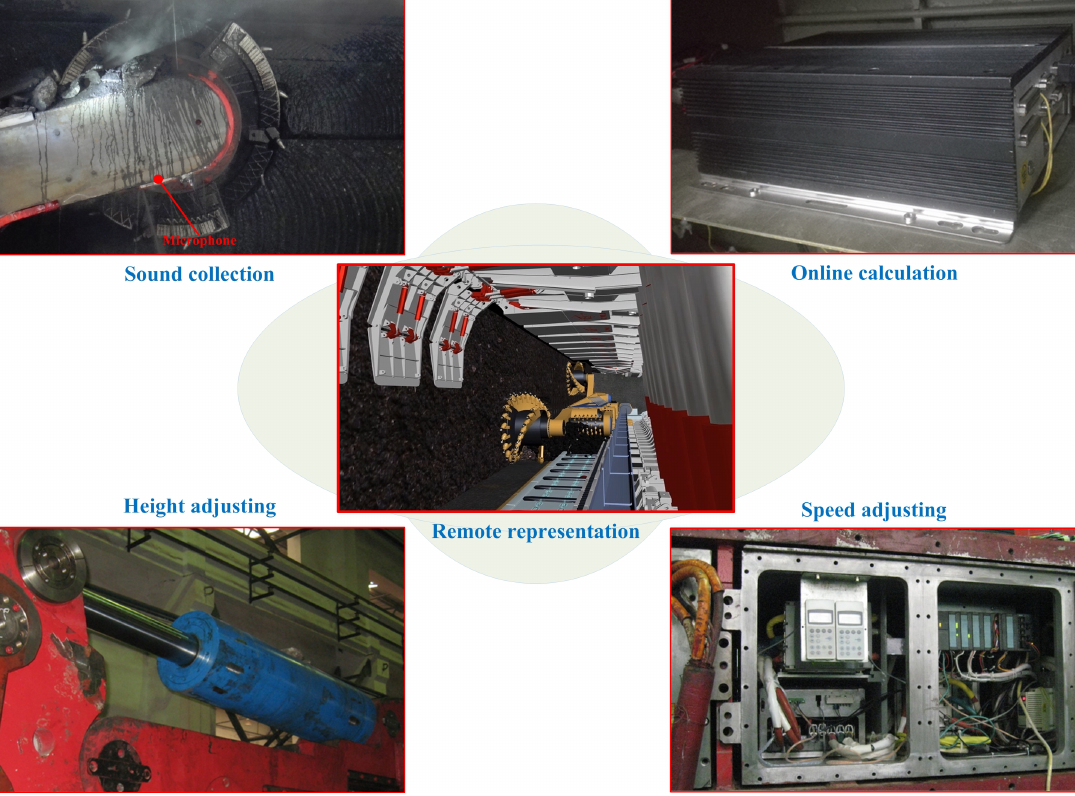
Figure 10. Online cutting pattern recognition system.